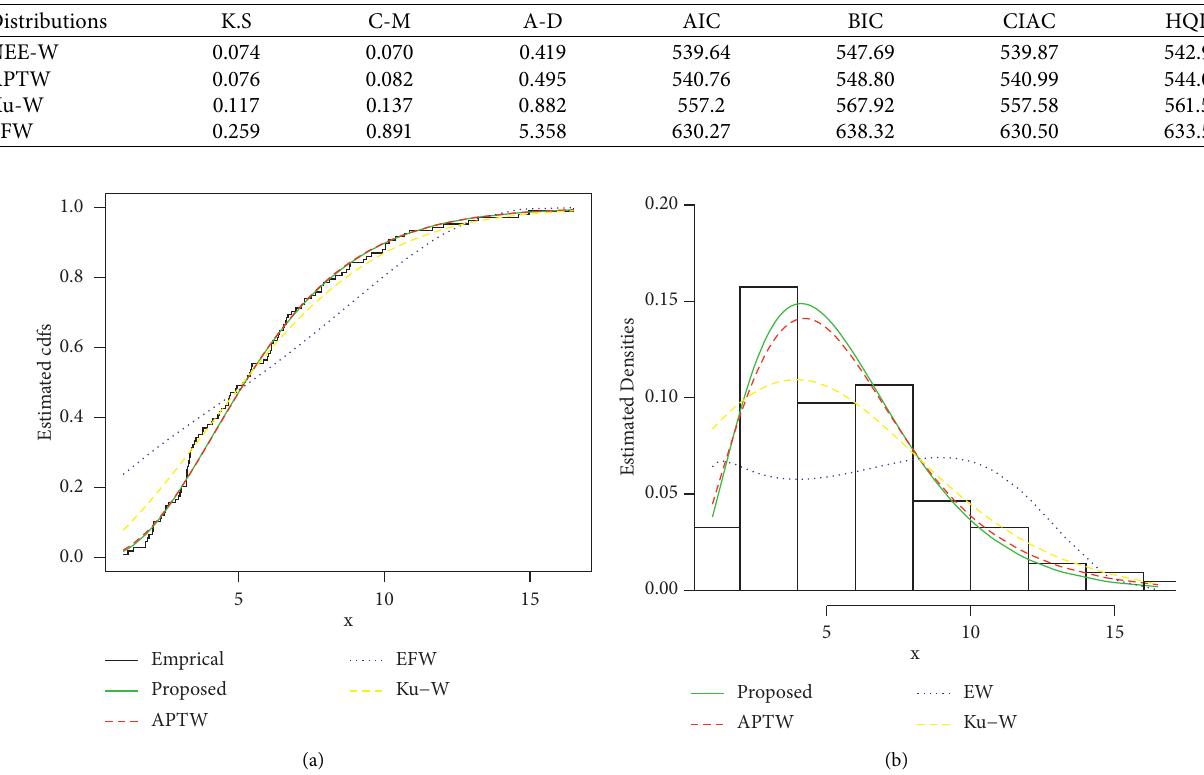
Figure 9: Showing the joint plots of CDF and pdf for the proposed and competing models using the COVID-19 data in